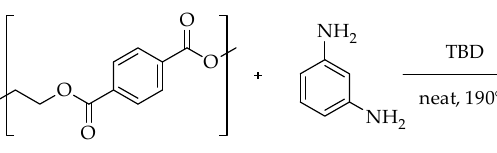
Figure 1. MPD-TPA-MPD synthesis from PET waste.